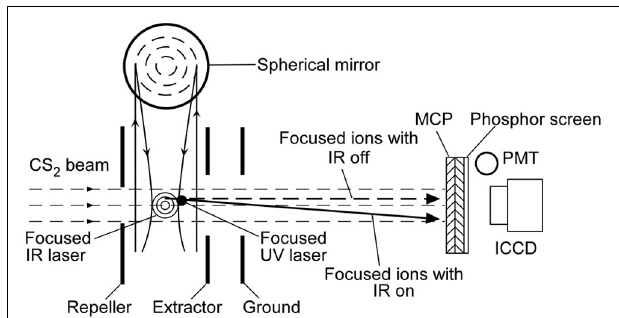
FIGURE 1 | Schematic of the experimental layout. The molecular beam propagates along the z -axis while the laser beam is along the x -axis. The molecular beam is deflected by an IR laser pulse along the y -axis and then ionized by a UV laser pulse.